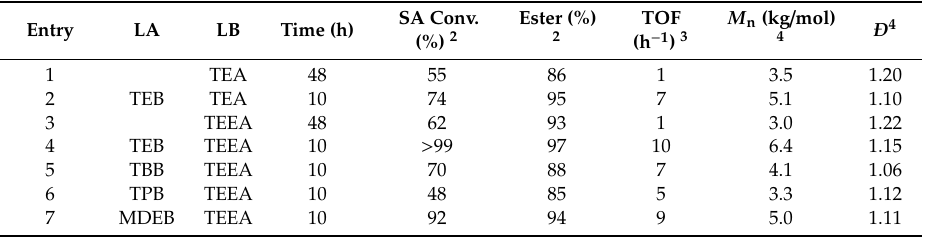
Table 1. SA / PO copolymerization catalyzed by LA / LB pairs 1